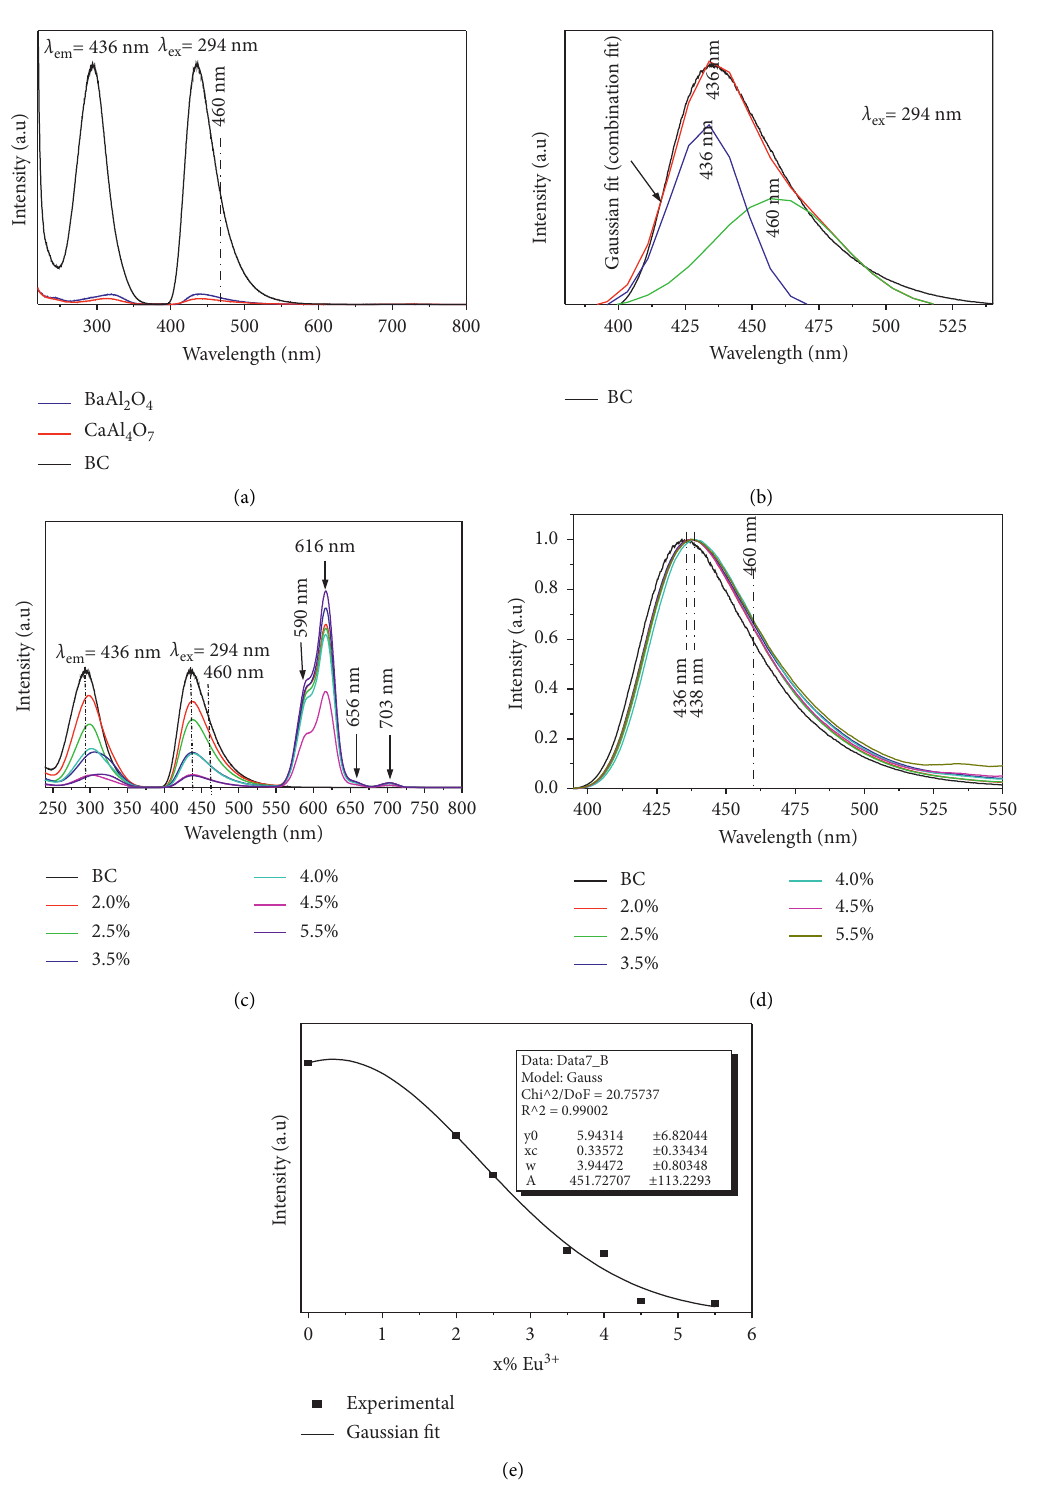
Figure 7: (a) Excitation and emission spectra of CaAl 2 O 4 , BaAl 2 O 4 , and BC, (b) the deconvolution of BC spectrum, (c) excitation and emission spectra of BC: x % Eu 3+ (0 ≤ x ≤ 5.5), (d) the normalized emission spectra of BC: x % Eu 3+ (0 ≤ x ≤ 5.5), and (e) the emission intensity of BC: x % Eu 3+ versus x % Eu 3+ (0 ≤ x ≤